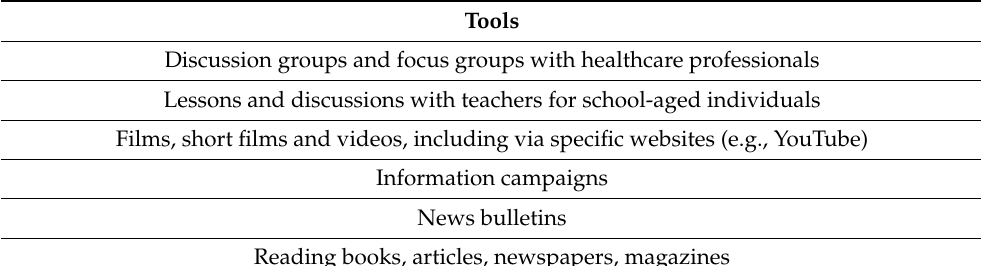
Table 4. Items selected in the category “Tools to deliver citizens’ educational initiatives“, listed by decreasing mean scores from the Delphi process.